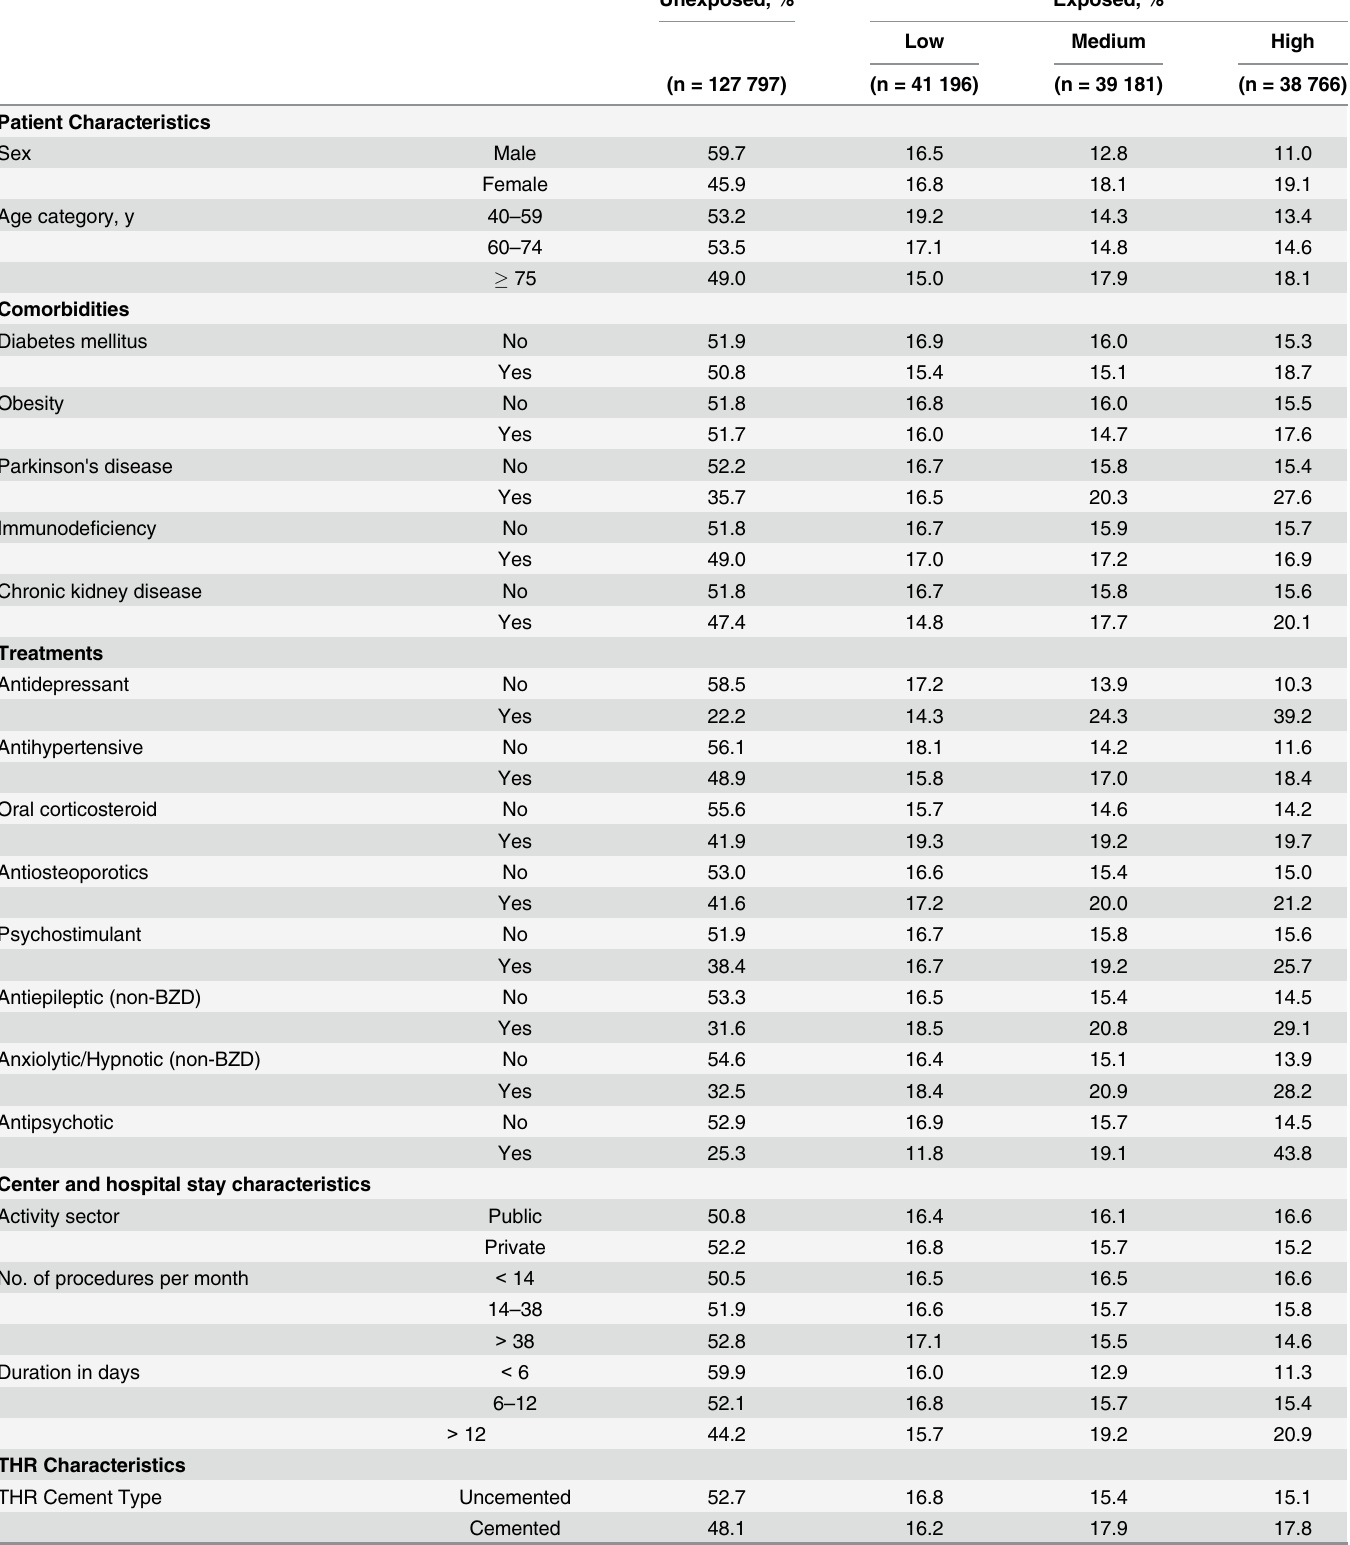
Table 2. Characteristics of the patients, centers, hospitals Stays and THR, according to exposure to BZDs.